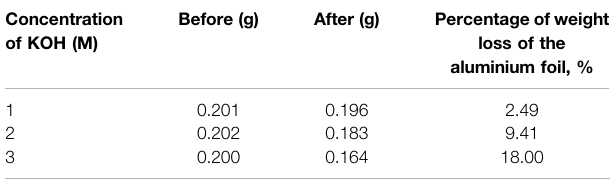
TABLE 1 | Weight loss of Aluminium anode under three different concentrations of KOH. Concentration Before (g) After (g) Percentage of weight of KOH (M)